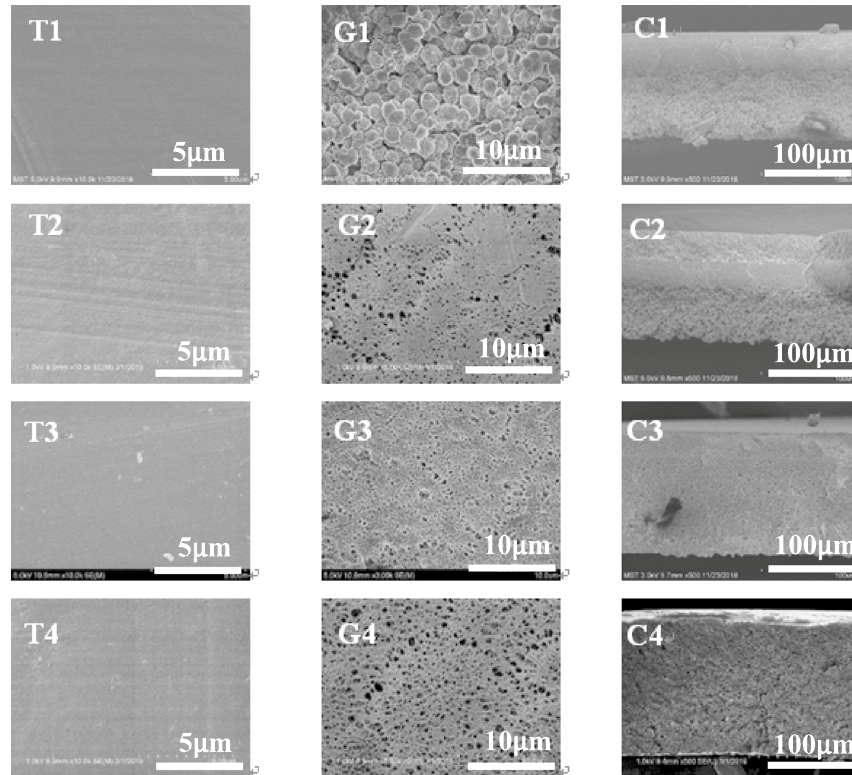
Fig. 3 SEM images of